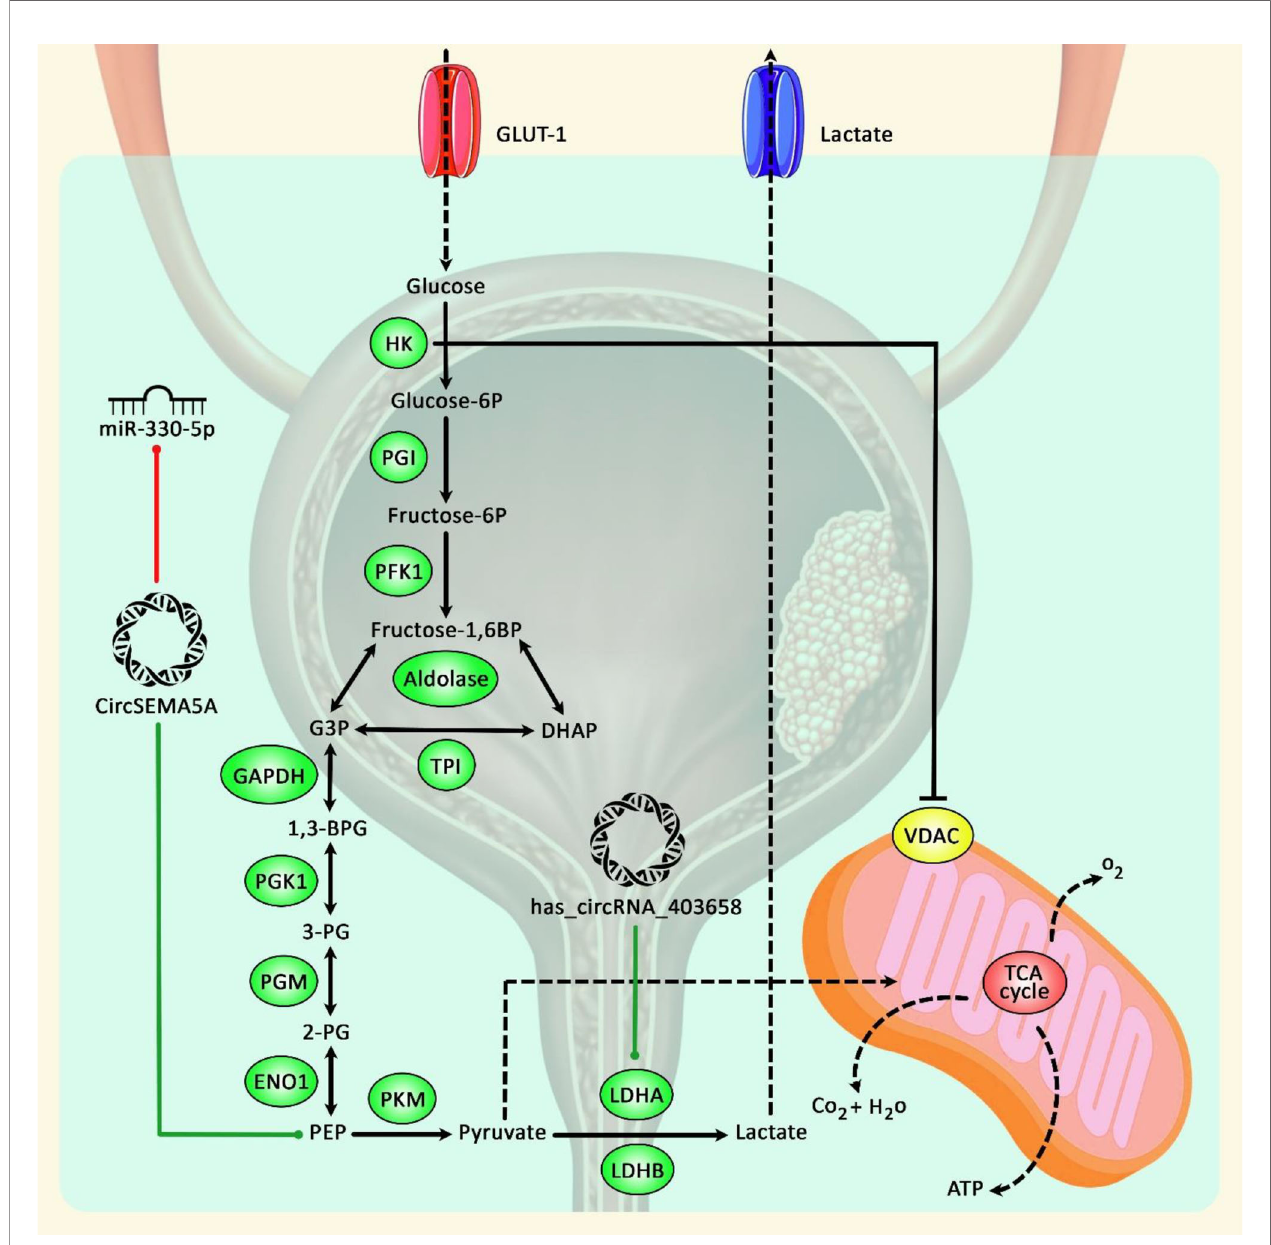
FIGURE 1 | A schematic diagram of the role of circRNAs in promoting bladder cancer progression via enhancing glycolysis. Accumulating fi ndings have suggested that upregulation of key glycolysis proteins could play a crucial role in cancer development. As an illustration, a previous study has authenticated that has_circRNA_403658 through upregulation of LDHA-mediated aerobic glycolysis could have a signi fi cant part in enhancing bladder cancer cell growth (17). In addition, another research has detected that circSEMA5A via sponging miR-330-5p could upregulate the expression level of ENO1, thereby elevating proliferation, invasion, angiogenesis, and glycolysis of bladder cancer cells by facilitating the activation of Akt and b -catenin signaling cascades (21). Green arrows indicate the upregulation of target genes by circRNAs, and red arrows depict inhibitory